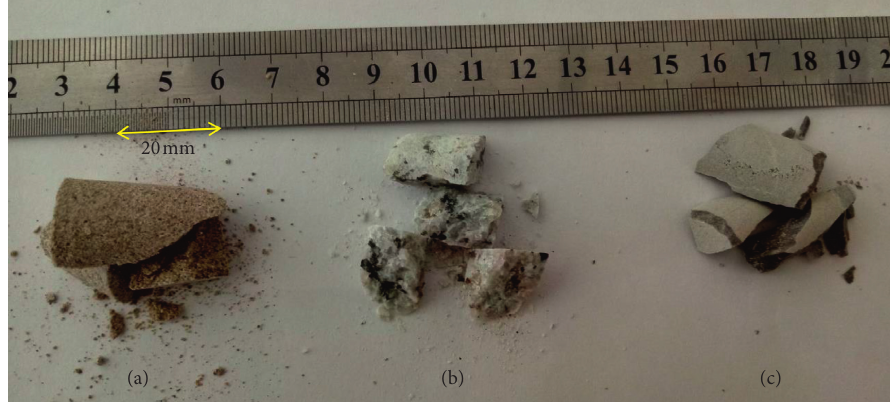
Figure 14: Debris of core columns under